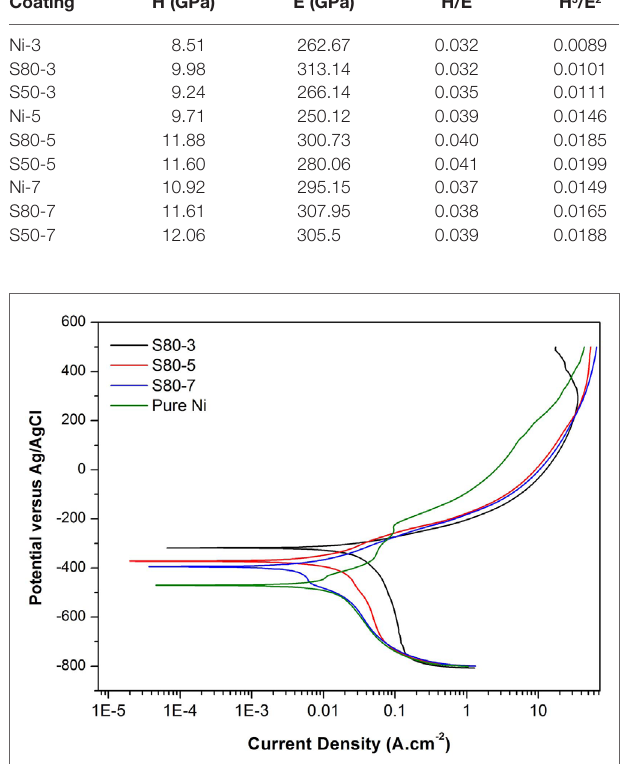
FigUre 5 | Potentiodynamic polarization curves of pure ni and ni–TiO 2 nanocomposite coatings deposited with 80 nm sized TiO 2 nanoparticles at 1 g l − 1 concentration and 3, 5, and 7 a dm − 2 current densities .